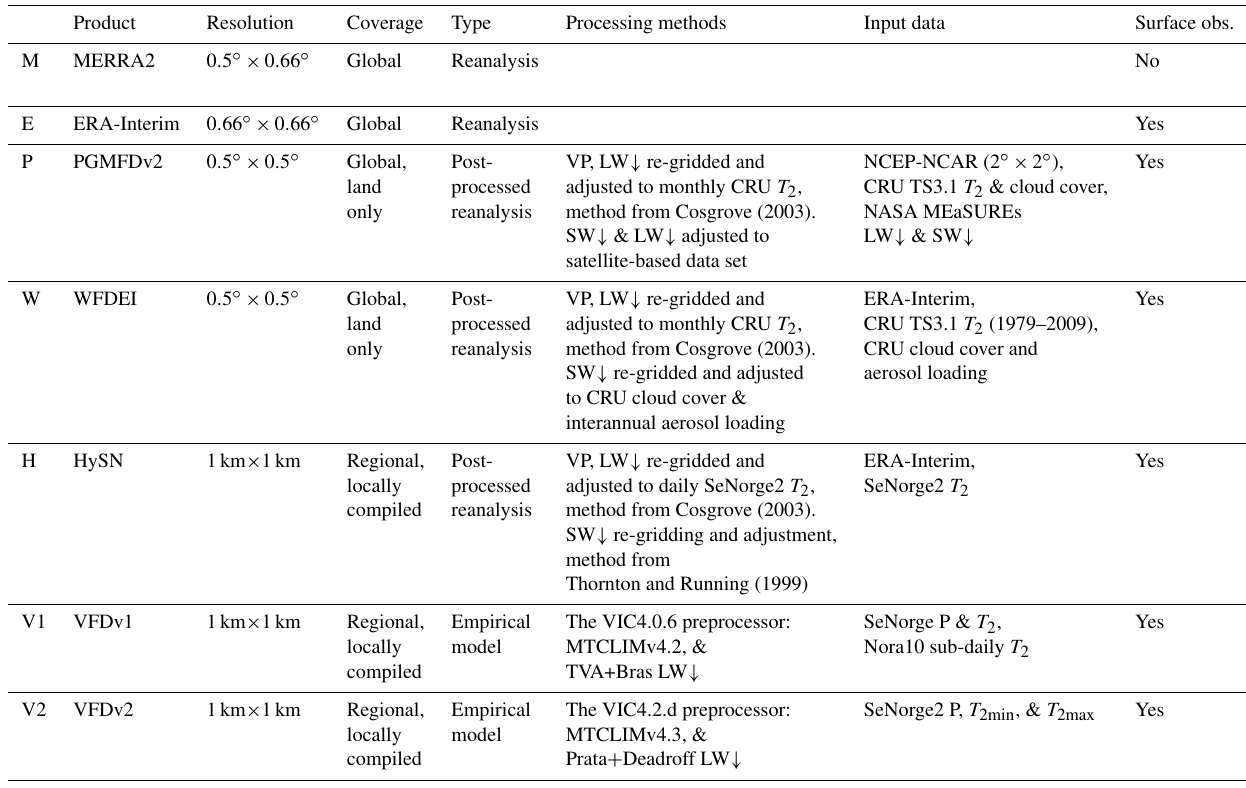
Table 1. The following data sets provide estimates of humidity, LW ↓ , and SW ↓ , which are then evaluated. Precipitation is denoted as P , 2m temperature as T 2 . The global data sets are retrieved from online repositories, while the data sets with regional coverage are compiled locally based on the stated input data, the VFD data sets using the VIC model’s preprocessor, and the HySN data set based on the methods outlined in the current study. Additional references are given elsewhere in the